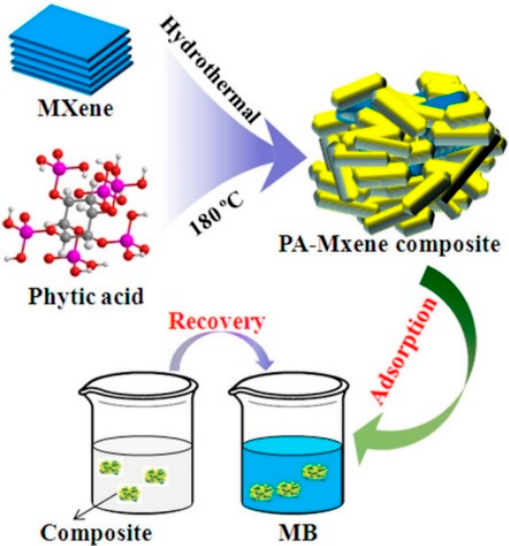
Figure 6. Schematic illustration of Mxene-based composites synthesized via the hydrothermal process. Reprinted with permission from Ref. [54]. 2020, Elsevier.